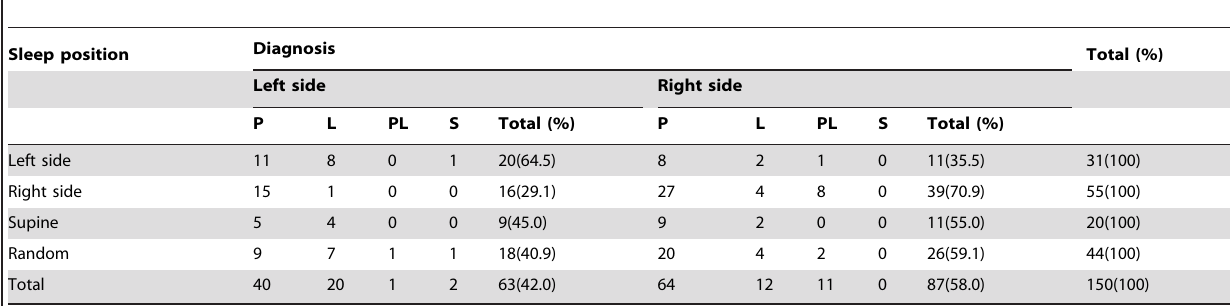
Table 4. The relationship between the side affected by BPPV and the habitual sleep position.